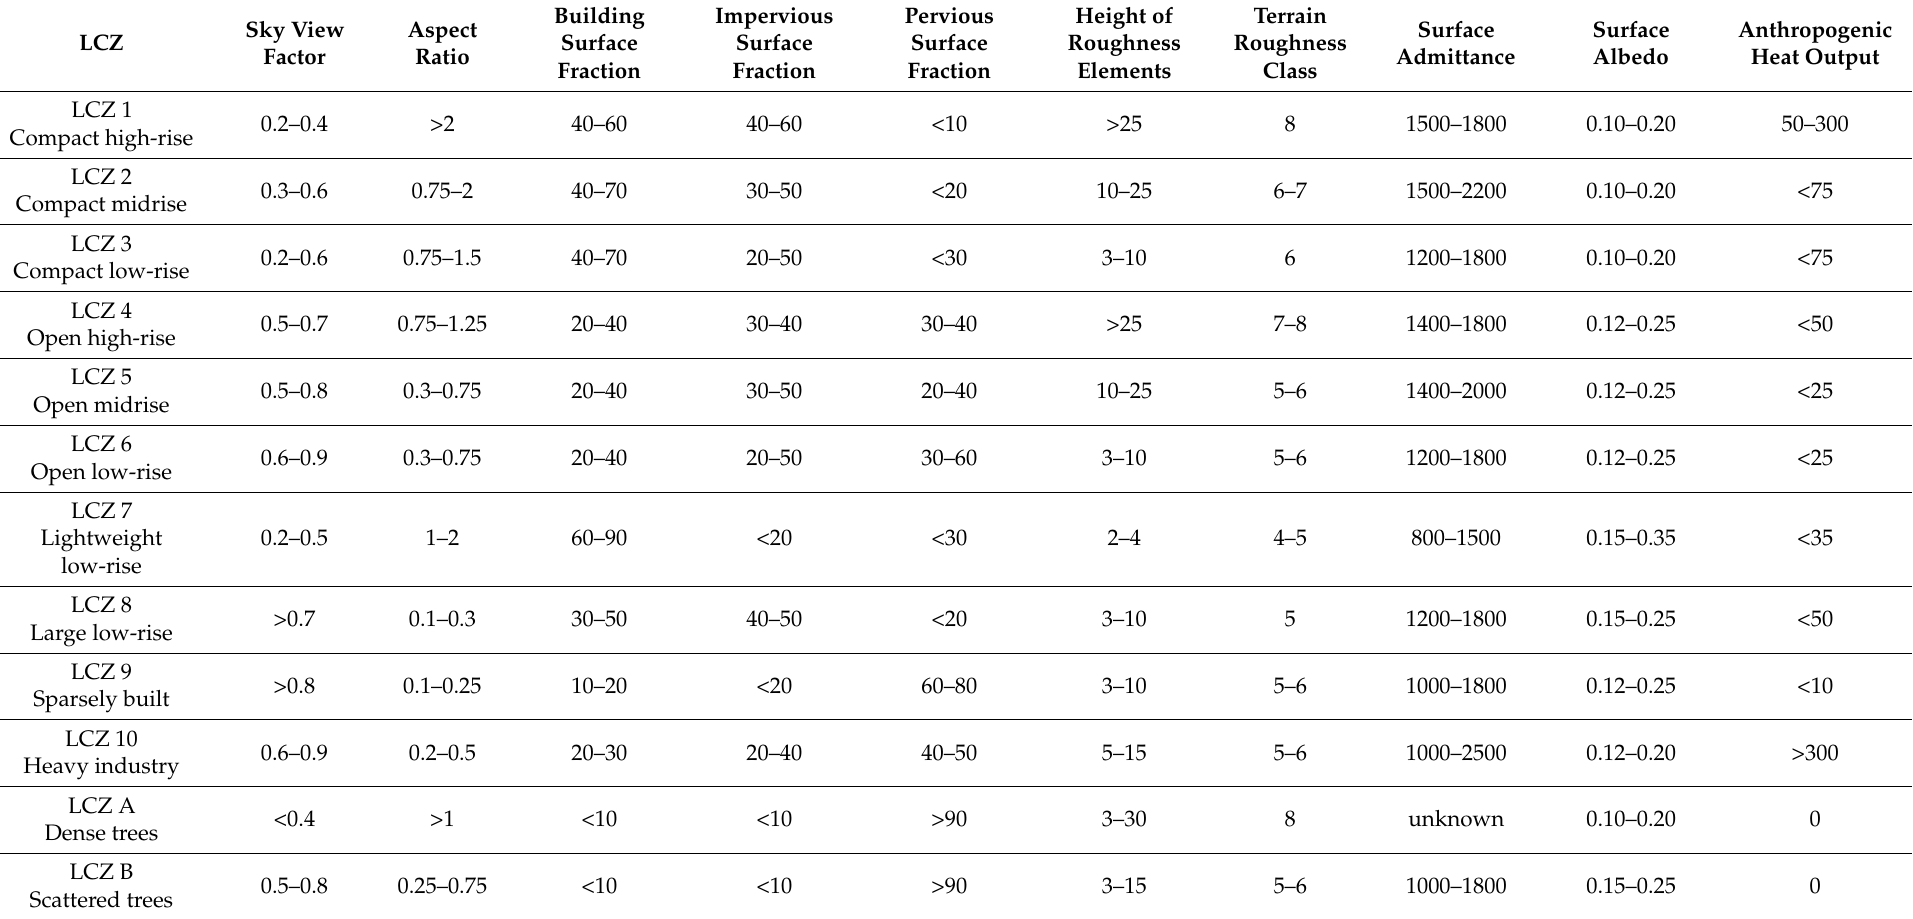
Table A3. Values of different index properties for LCZ